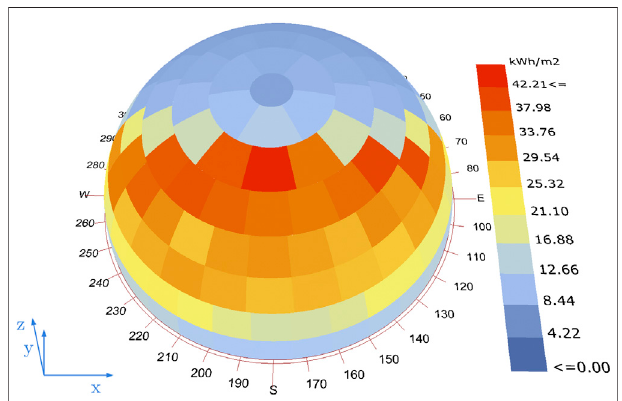
FIGURE 2 | Annual total irradiation, visualized for skydome of Geneva, Switzerland. Typical weather data from DOE